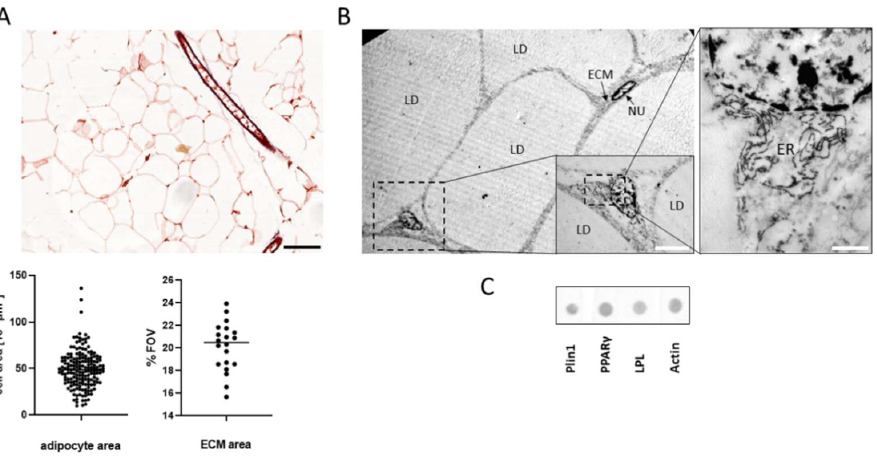
Figure 5. Tissue morphology and protein expression. ( A ). Histology analysis of adipose tissue (scale bar = 100 µ m) used to analyze single-cell (n = 390) of adipocyte size and ECM area in FOV (n = 20) of the adipose tissue. ( B ). TEM images of adipocytes and a fibroblast were visualized. (LD-lipid droplet; ECM-extracellular matrix; NU- nucleus; ER- endoplasmic reticulum, Magnification: × 20,000 ( right ), scale bar = 1 µ m; × 5000 ( left ), scale bar = 5 µ m. ( C ). Immunoblotting of adipose tissue proteins shown by Dot-blot.